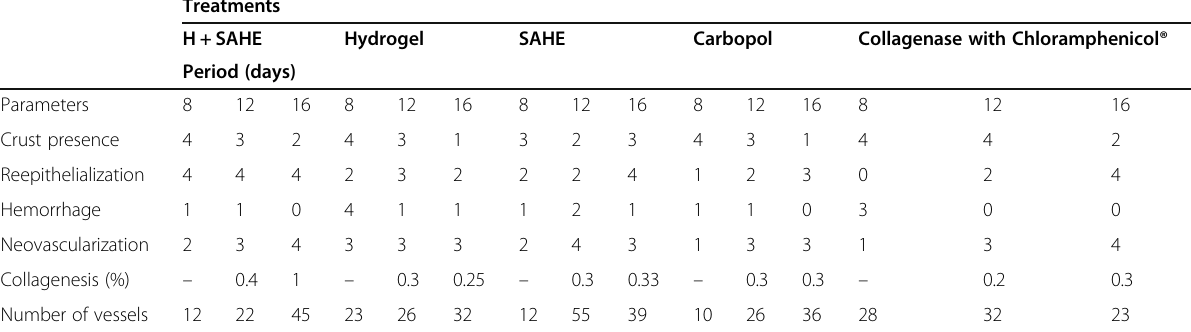
Table 3 Histological Parameters of the Diabetics Rats Treatments H + SAHE Hydrogel SAHE Carbopol Collagenase with Chloramphenicol® Period (days) Parameters 8 12 Crust presence 2 Reepithelialization 4 4 2 3 Hemorrhage 1 Collagenesis